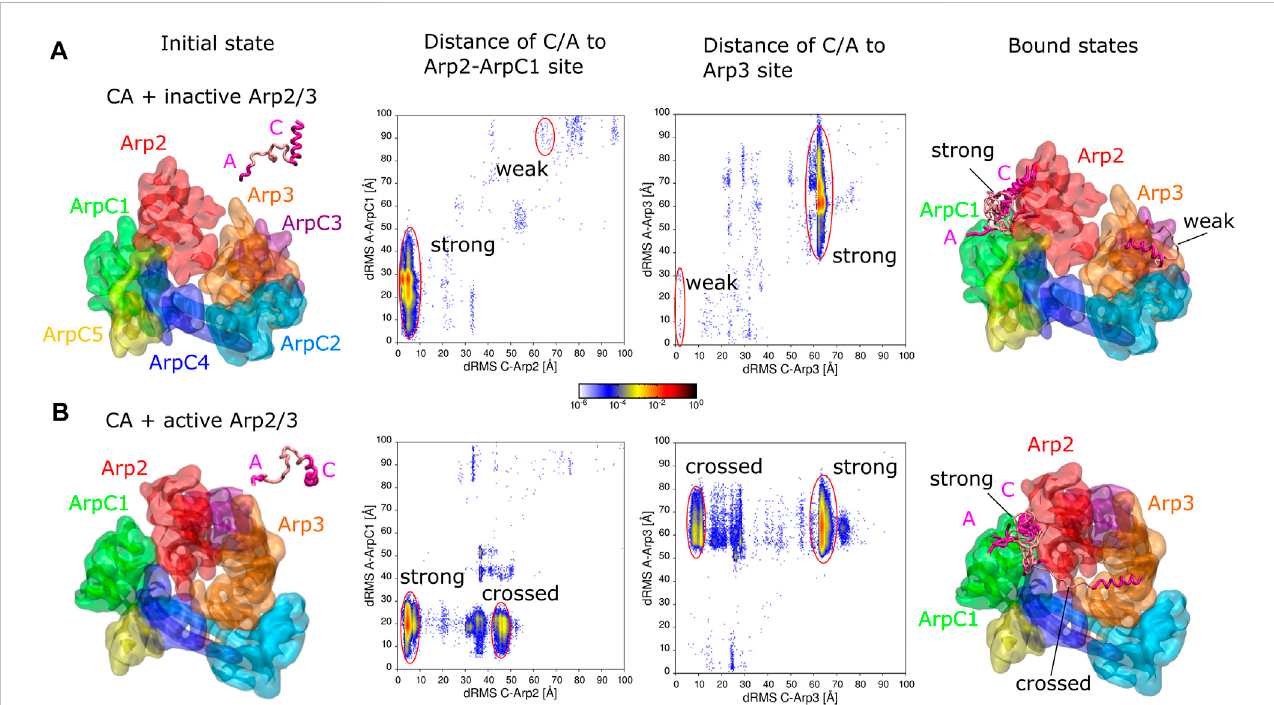
FIGURE 1 SimulationsofCAdomainbindingtoinactiveandactiveArp2/3complex. (A) BindingofCAtoinactiveArp2/3complex.Leftsnapshot:initialcon fi guration with CA domain starting separated from Arp2/3 complex. Middle plots: 2D distribution of dRMS values for C and A domains relative to the Arp2-ArpC1 and Arp3 binding sites. dRMS was calculated every 10 time steps. Data binned over .5 × .5 Å 2 . Regions corresponding to strong and weak binding hotspots indicated with red lines. Right snapshot: Bound con fi gurations corresponding to weak and strong hotspots, with a few overlapping examples shown for the strong case. (B) Same as panel (A) , but for active Arp2/3 complex, with representative bound states shown for the strong and crossed bound states. Both simulations performed in a cubic box of side 300 Å for ~1.6 μ